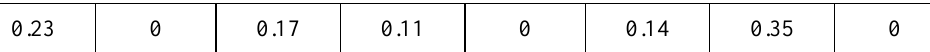
Figure 3. The example of proposed chromosome used by